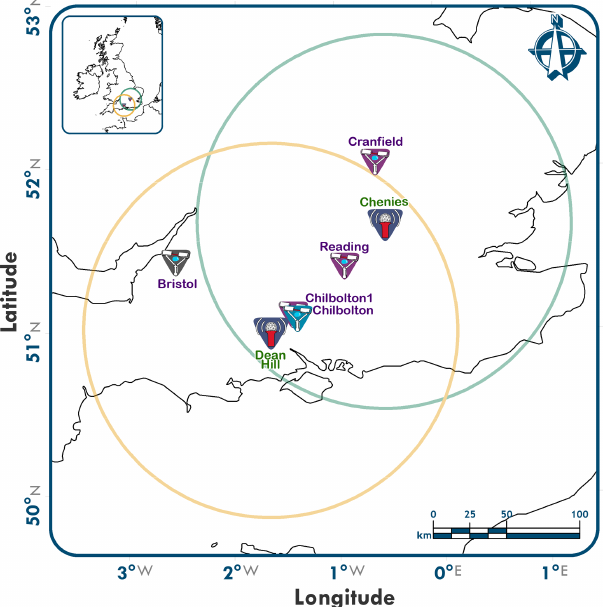
Figure 1. Location of the radars (Chenies and Dean Hill) and dis- drometers (Bristol, Chilbolton, Cranfield and Reading). The circles represent the coverage of each radar at a distance of 115km (maxi- mum coverage of the radars operating at short pulse